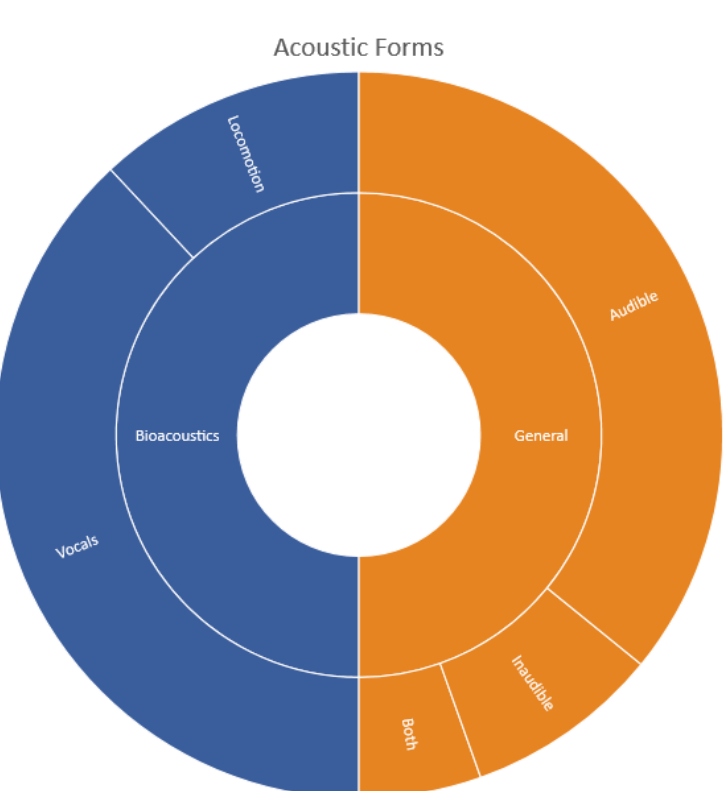
Figure 7. Forms of sound for bioacoustics and general acoustics